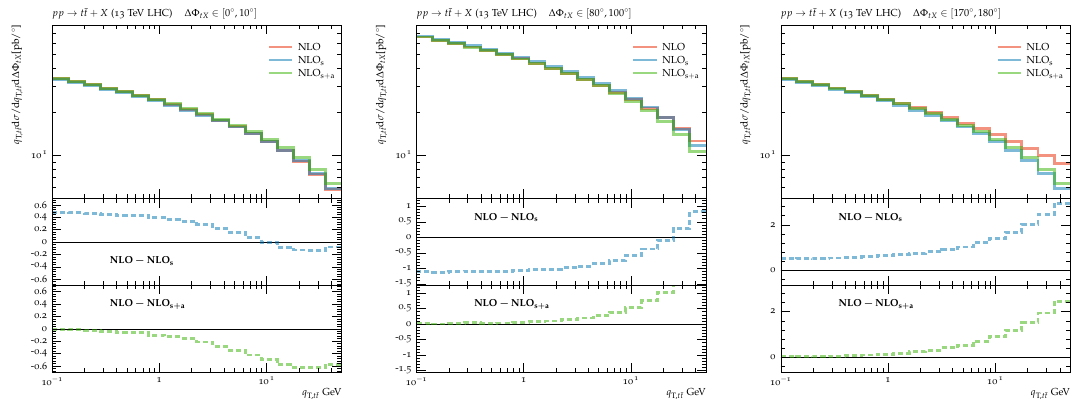
/ (d q T d∆Φ tX ) , t ¯ t